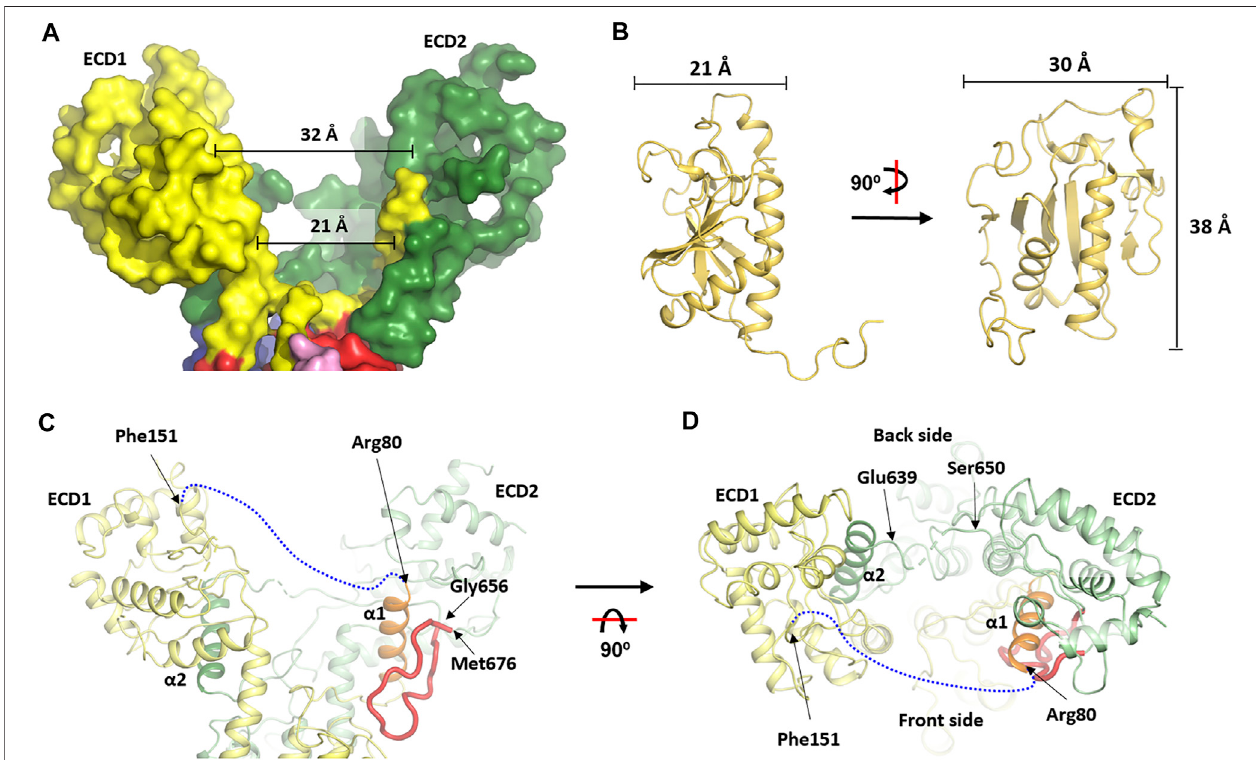
FIGURE 3 | The asymmetry of the extracellular domain and the conformational changes at the transmembrane domain. The two interconnected extracellular domains (ECDs) form the two arms of a slingshot and creates a cavity that is more open at the “ front ” side than at the “ back ” side. (A) surface view of the ECD part. (B) Dimension ofthe human HhN (PDB: 3M1N) (Pepinsky et al., 2000) which isclose to the size of the cavity in (A) . (C, D) Cartoon representation ofthe wb Disp structure at thetwoECDsviewedfromtwodifferentangles.Variouspartsarelabeledwhenappropriate.AbluedashlineindicatestheECD-connectingloopthatwasinvisiblein the current